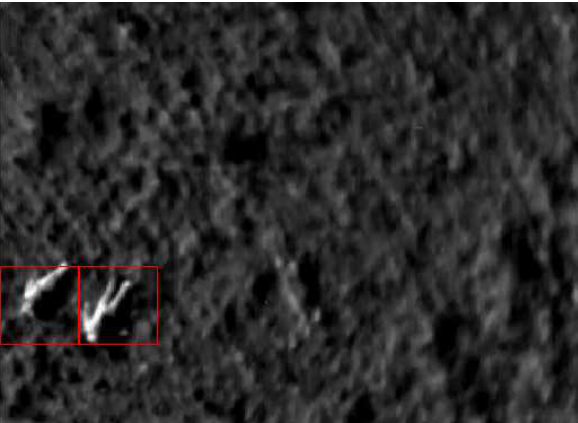
Figure 3: Two persons lying on the floor, sensed with a GSD of 5cm x 5cm, and the AFD mechanism providing its